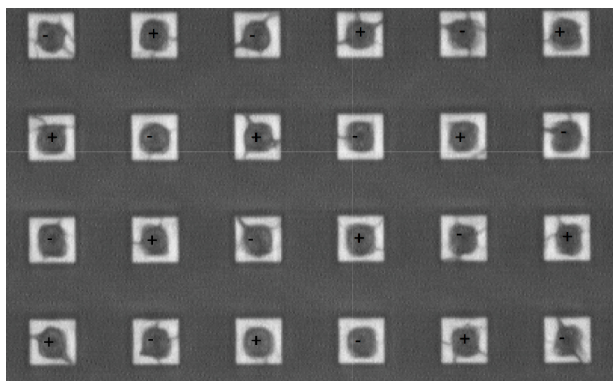
Figure 2. Microphotograph of the humidity-sensing surface.